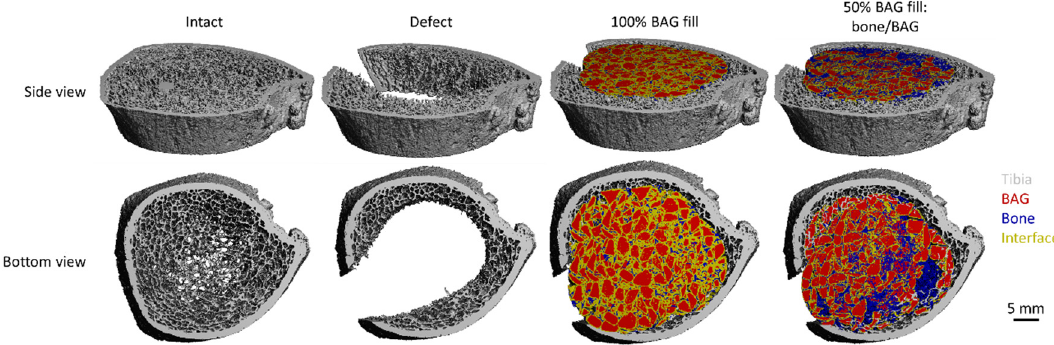
Figure 3. The four conditions of the tibia model viewed from the side and the bottom of the scanned part of the